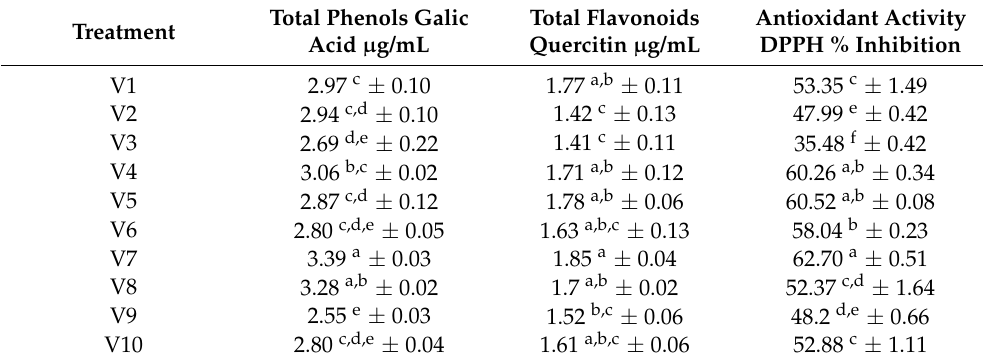
Table 5. Quality of wheat grass